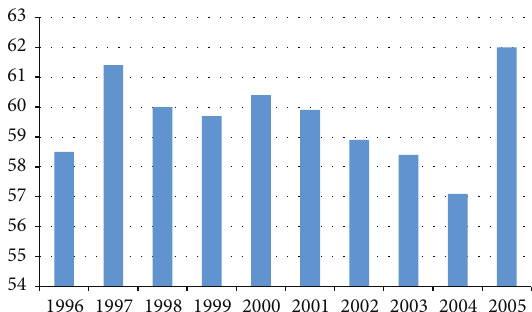
Figure 2: Variation in mean age (years) of patients presenting for